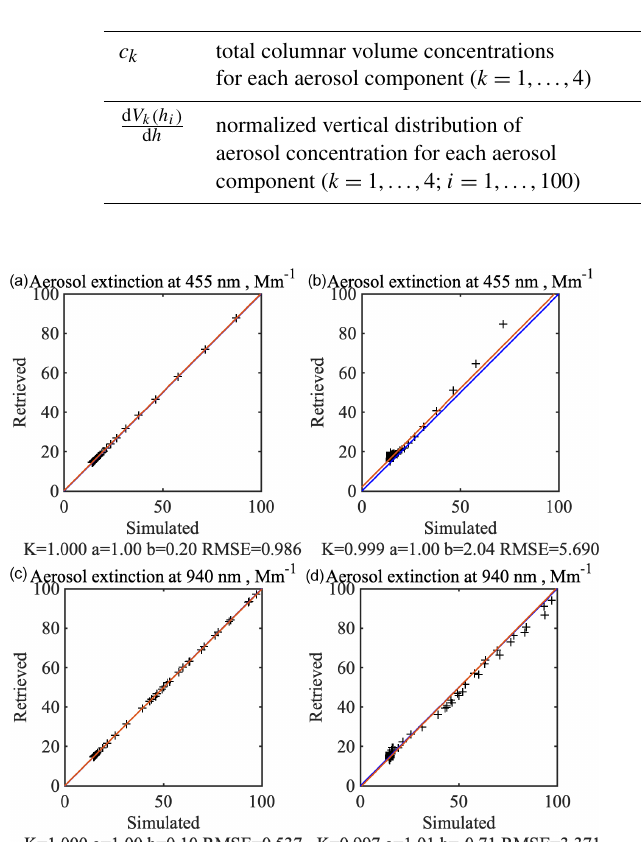
Figure 19. Comparison between simulated and retrieved aerosol extinction profiles at 455nm (a, b) and 940nm (c, d) in noise- free (a, c) and noisy (b, d) conditions.